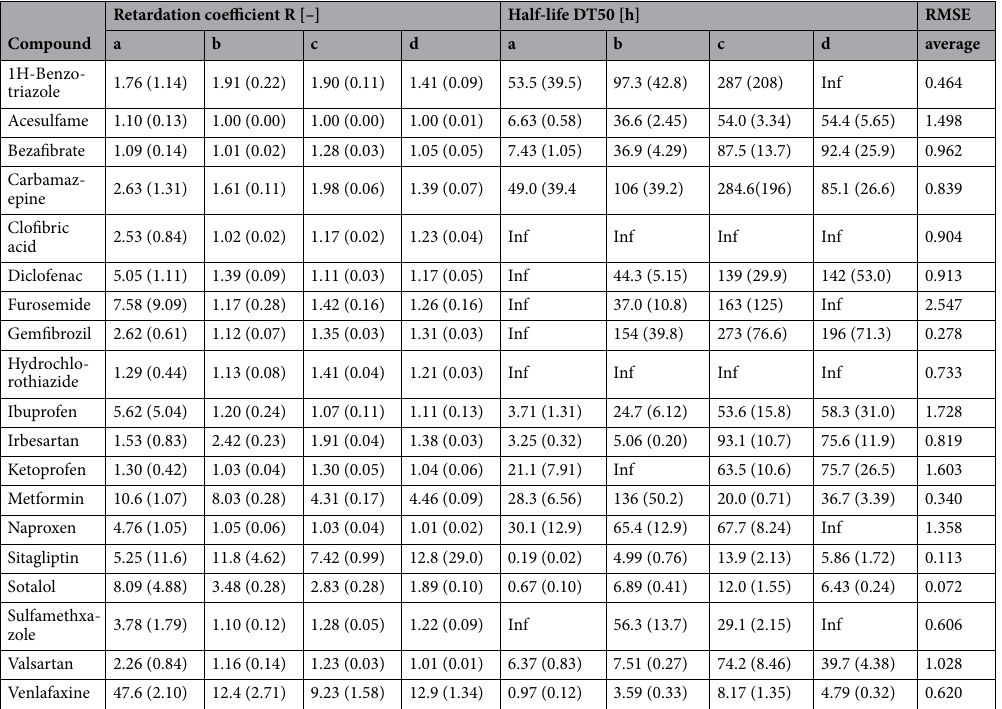
Table 2. Medians of parameter estimates for half-lives (DT50s) and retardation coefficients R of selected parent compounds and respective inter quartile ranges (in brackets) on Flowpaths a, b, c and d of Flume 1, as well as average root mean square errors (RMSE). DT50s exceeding the thresholds (Supplementary Table S4) were set to infinity (inf). For respective values of degradation rate constants k , see Supplementary Table